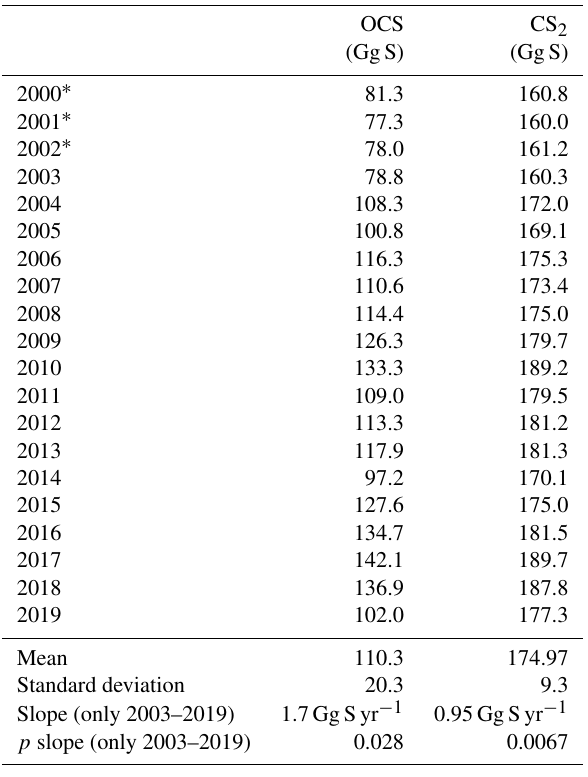
Table 2. Globally integrated annual emissions of OCS and CS 2 for each year in 2000–2019, together with descriptive statistics and trends.